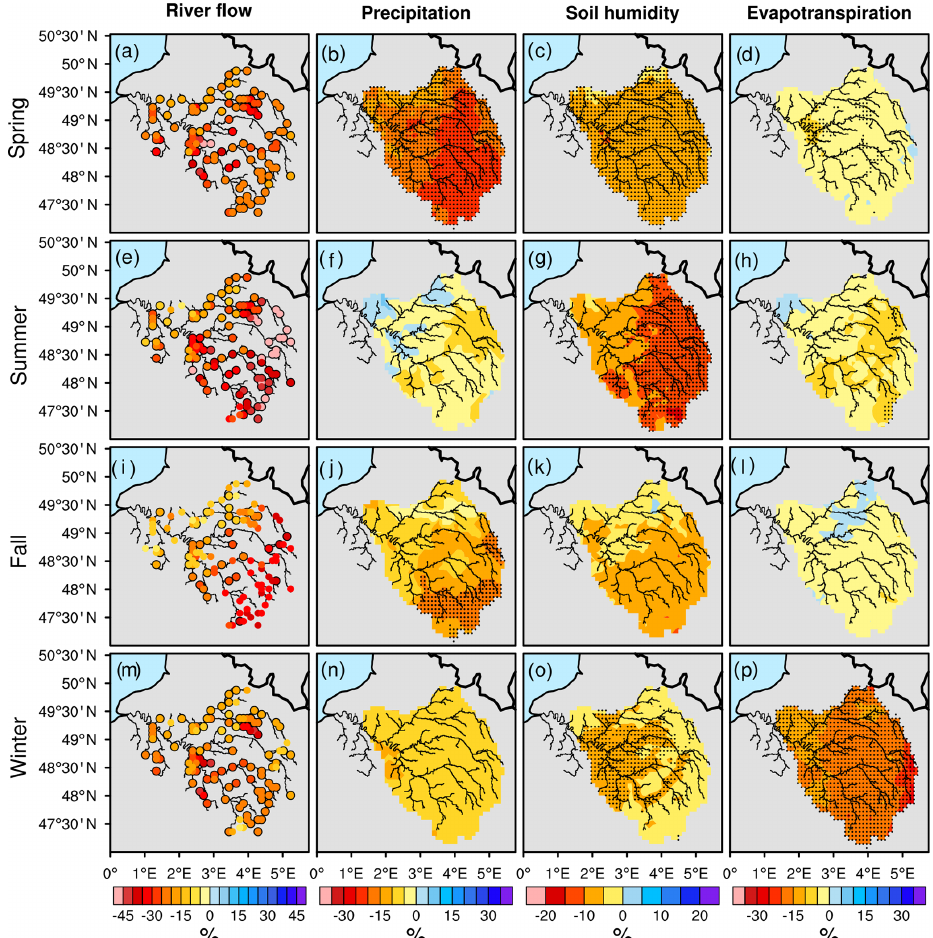
Figure 8. Relative differences (%) in detrended (a, e, i, m) simulated river flows, (b, f, j, n) precipitation, (c, g, k, o) soil wetness index (SWI) and (d, h, l, p) evapotranspiration, between the negative multidecadal phases of the Seine river flows (1885–1905 and 1940–1960) and the positive phases (1910–1930 and 1975–1995). The reference is calculated as the average of these four periods. (a–d) Winter, (e–h) spring, (i–l) summer and (m–p) autumn. Simulated river flows, precipitation, SWI and evapotranspiration come from the Seine reconstruction. Black circles and dots show where the differences are significant based on a Student’s t test with a p value < 0.05.